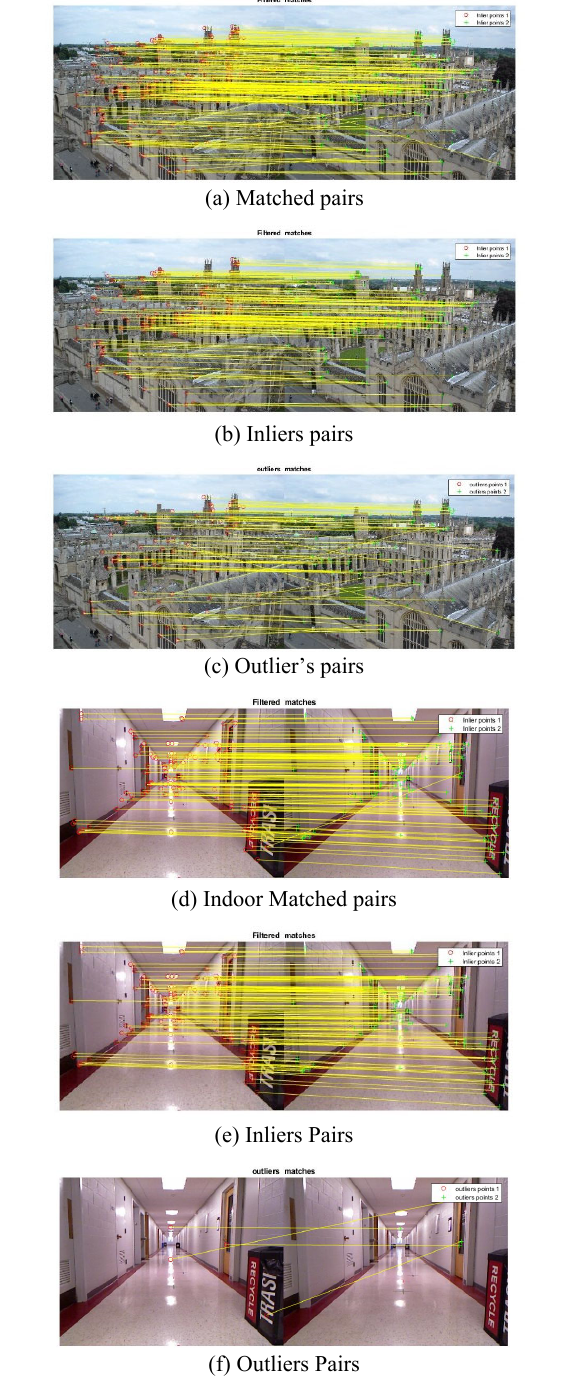
Figure 10: Executing the algorithms on the image pairs Oxford dataset (a-c) and SPIN lab dataset